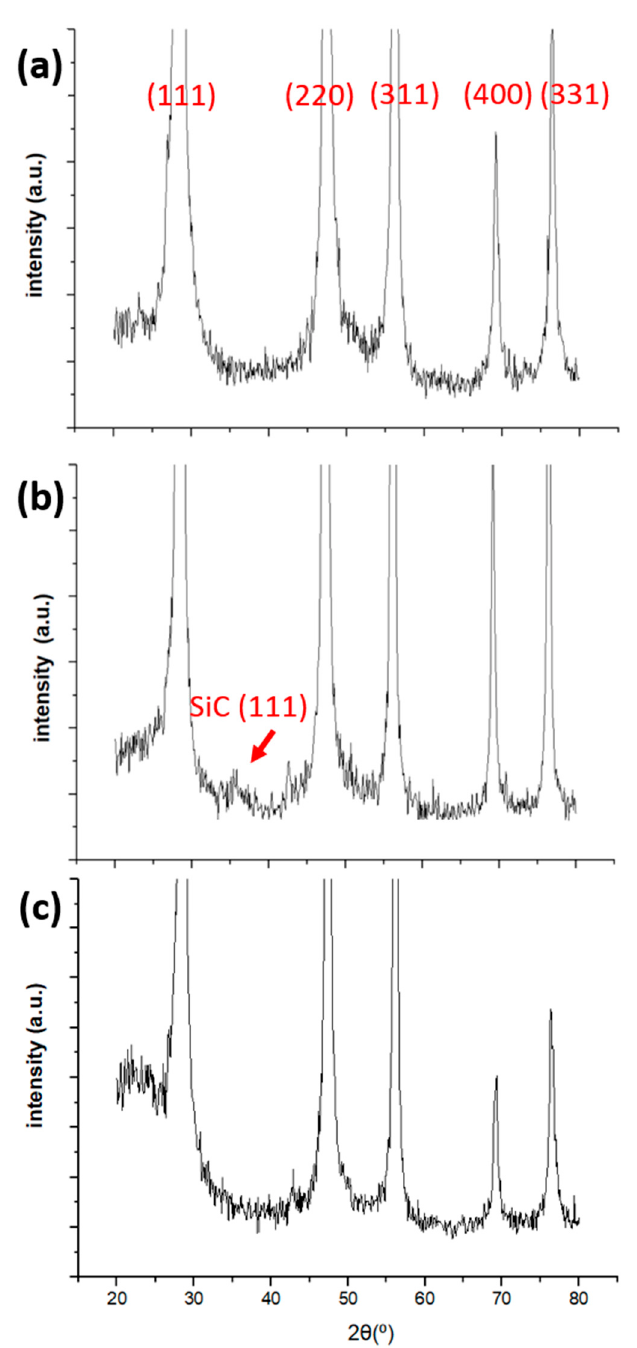
Figure 4. X-ray diffraction patterns of ( a ) pristine silicon flakes, ( b ) silicon flakes after 5-h thermal carbonization, and ( c ) silicon flakes after 1-h thermal carbonization.